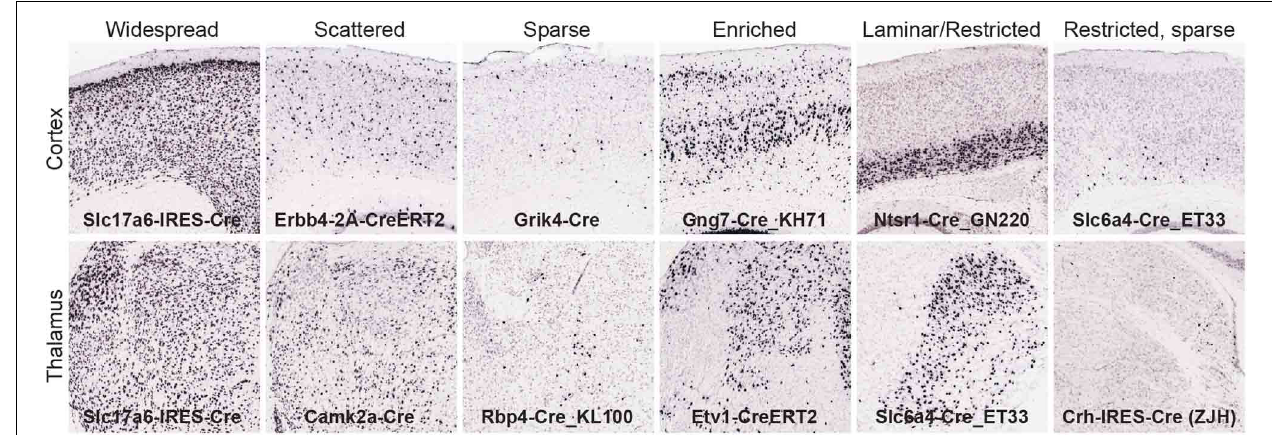
FIGURE 2 | Manual analysis of Cre reporter expression patterns across the brain. To aid in interpretation and further mining of the informatics-derived expression energy values, expression patterns were visually classified into one of six categories and recorded in